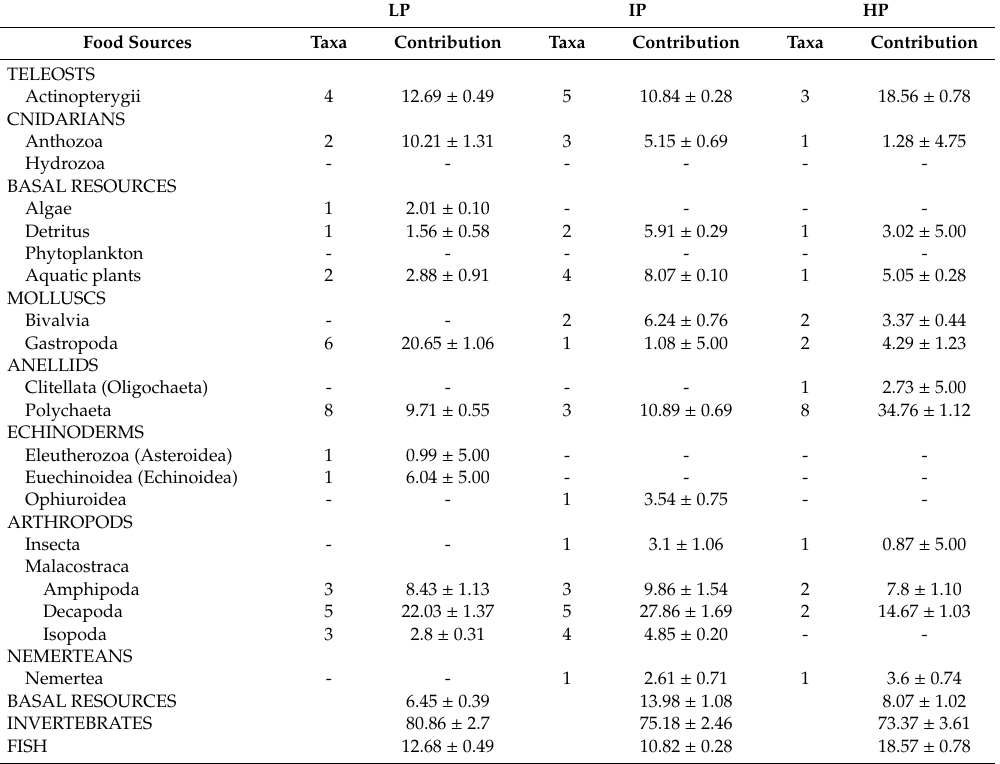
Table 4. Diet composition of Diplodus annularis in each lake. Proportional contribution (in %) of food sources to the diet of D. annularis obtained from ITU-based mixing models. LP: low anthropogenic pressure, IP: intermediate anthropogenic pressure, HP: high anthropogenic pressure. The contribution of each food source is reported as the mean ( ± s.e.). “Taxa” indicates the number of taxa belonging to the respective group in the diet of D. annularis. The overall contribution of basal resources, invertebrates and fish is reported as the mean (%) ±